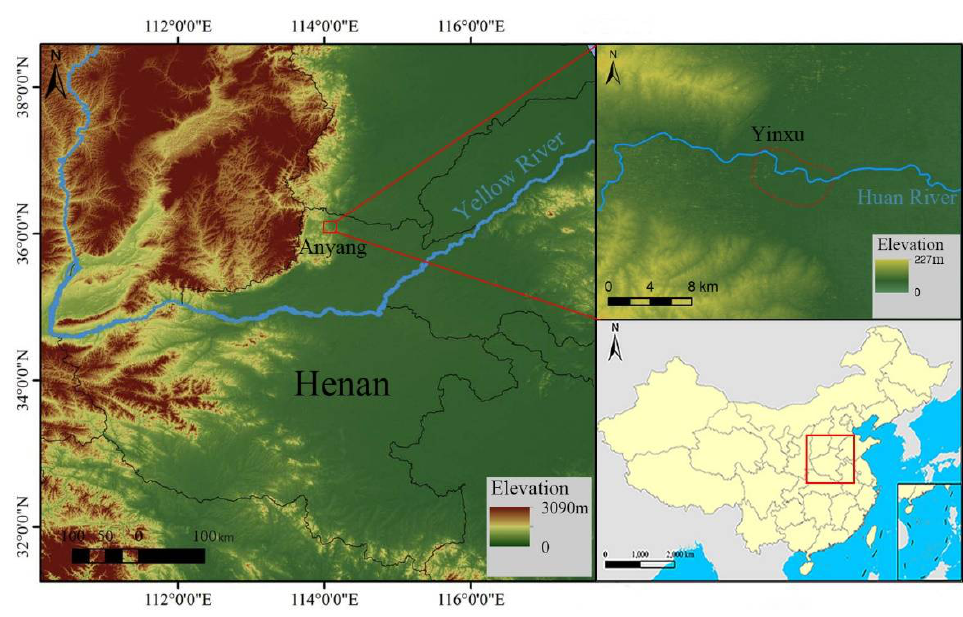
Figure 1. Geographical location of the Yinxu. Table 1. Cultural phase division of